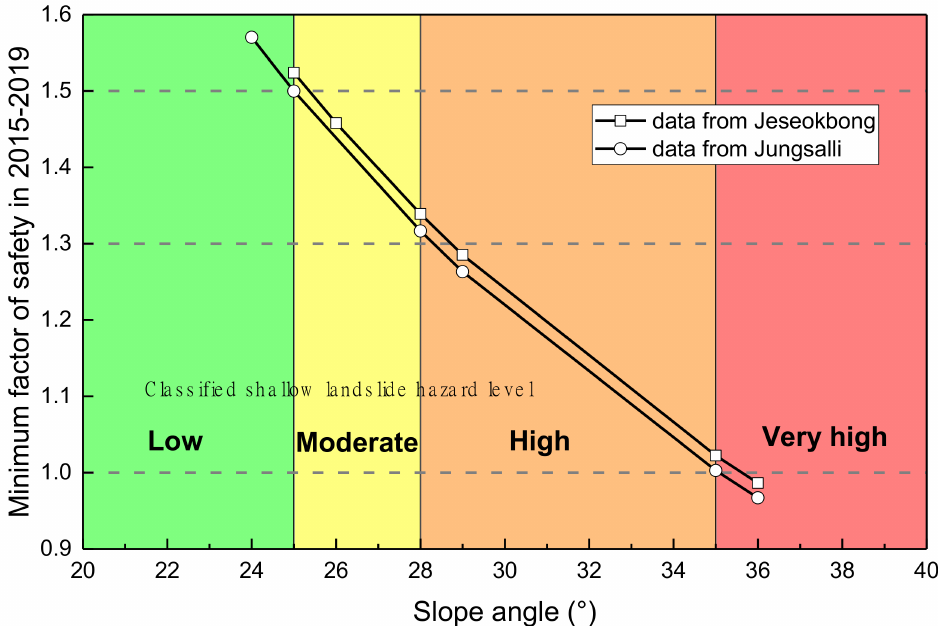
Figure 15. Minimum factor of safety values according to slope angle within the monitoring period and determination of landslide hazard levels.